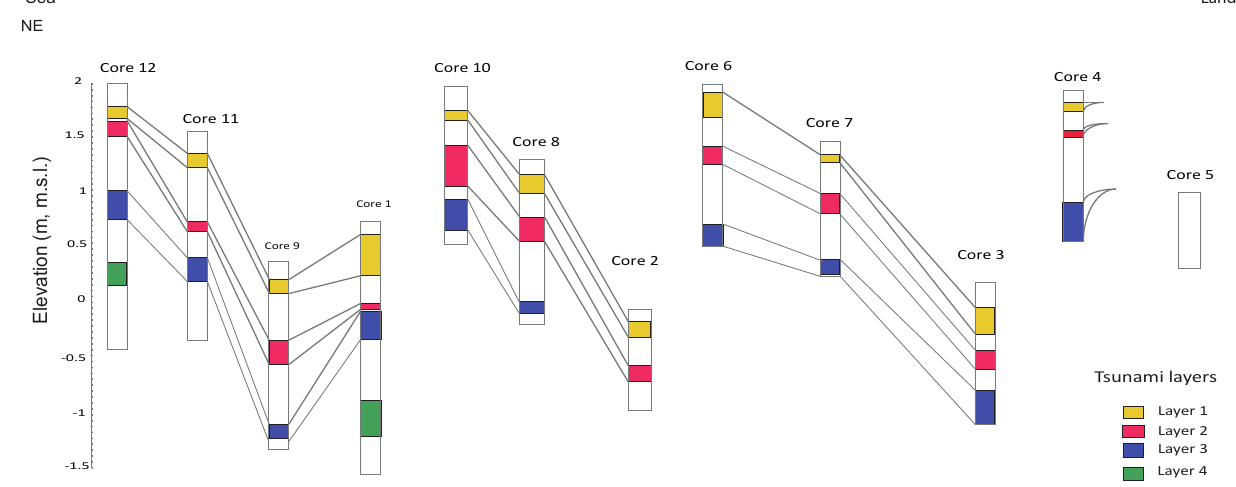
Figure 7. Depth distribution of tsunami layers in cores at the El Alamein site (see core locations in Fig. 2b). The depth correlation of paleotsunami layers indicates the consistent succession of deposits in the lagoon. Deposits of layers 1, 2, and 3 are related with tsunami events AD1870, AD1303 and AD365 of the eastern Mediterranean Sea (see Fig. 6 and Table 1). Layer 4 corresponds to tsunami event 1491–1951BC and is not reported in tsunami